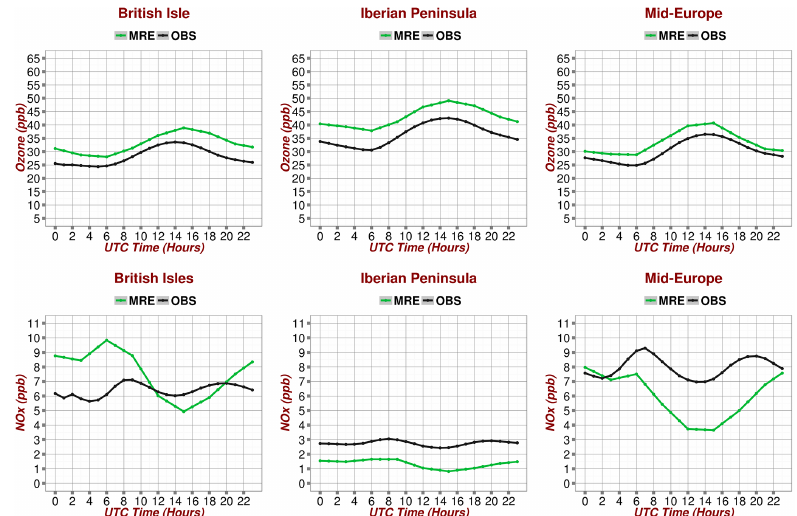
Figure 10. Mean diurnal cycle of near-surface O 3 (top panel) and NO x (bottom panel) based on observations (solid black line) and MRE (green line) for the subregions BI, IP, ME during summer over the period